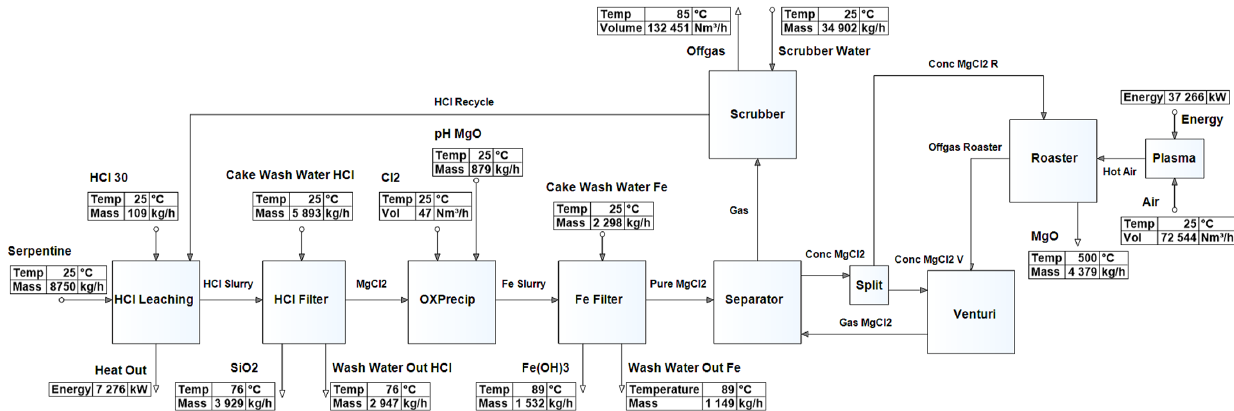
Figure 3. Preliminary mass and energy balance summarizing the input and output streams from leaching to roasting. The assumed 8.75 t/h of raw material input leads to an annual plant capacity of 70,000